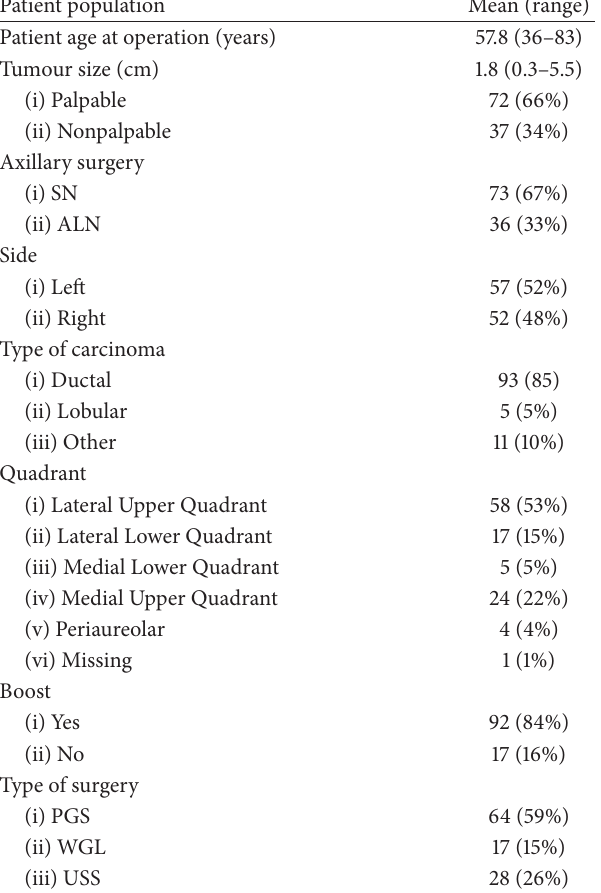
Table 2: Patient and tumour